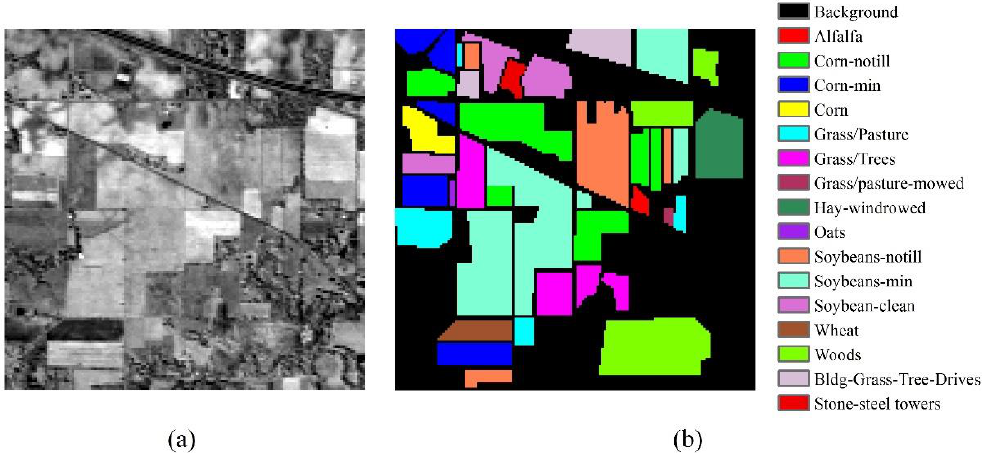
Figure 4. Airborne Visible/Infrared Imaging Spectrometer (AVIRIS) Indian Pines ( a ) sample band (band 100), and ( b ) ground truth image.